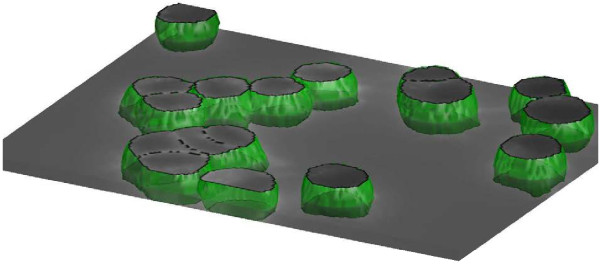
3D view of the segmentation in Example 6. The obtained segmentation is truly a 3D segmentation field. For visualization purposes the cells have been cut at plane 20.